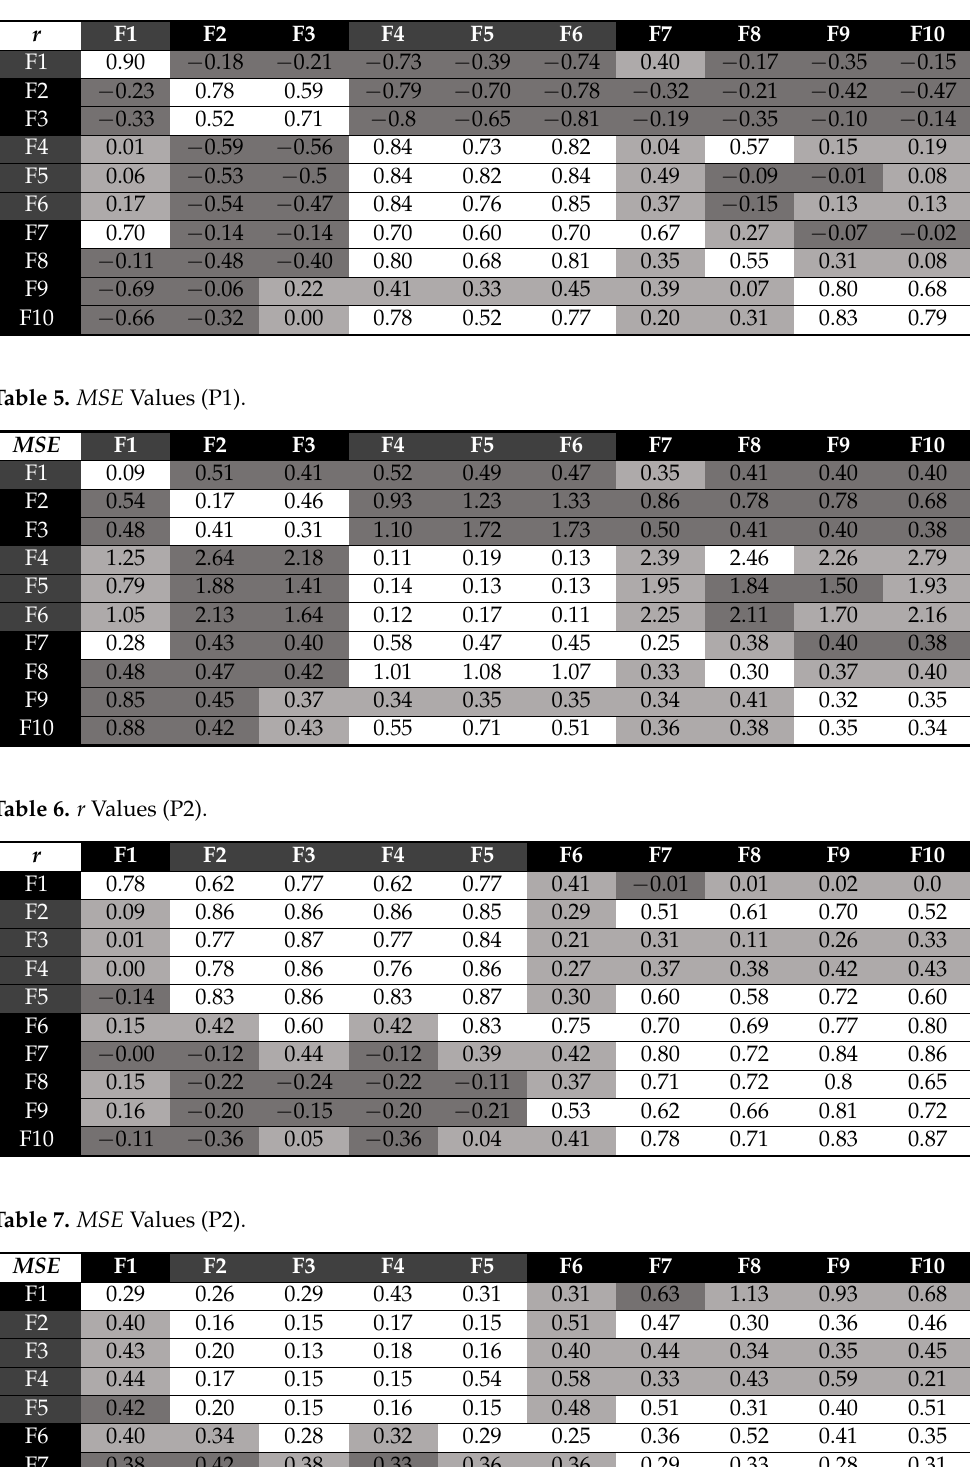
Table 4. r Values (P1).